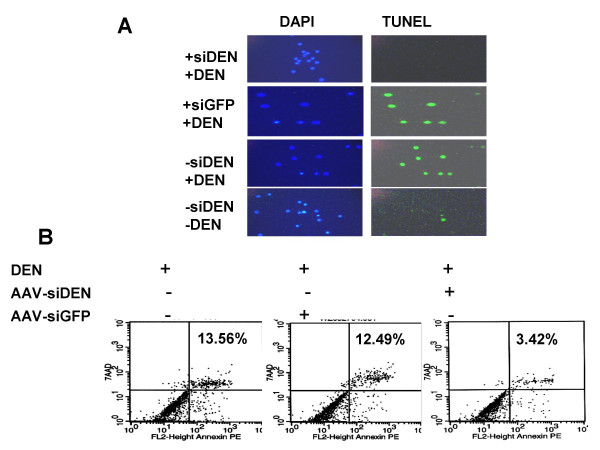
AAVsiDEN reduces apoptosis in human DCs infected with DEN-2. DCs were isolated from human peripheral blood and infected with AAVsiDEN followed by DEN-2. Five days after infection, DCs were put onto slides and apoptosis was determined using the terminal dUTP nick end-labeling assay (TUNEL). Nuclei were stained with diamidinophenylindole (DAPI). Representative fields were visualized by fluorescence microscopy.